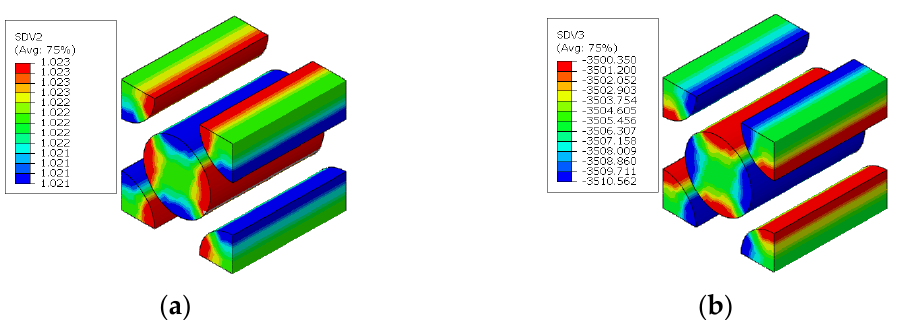
Figure 25. Failure indices and stress states in the fiber for fiber diamond distribution model. ( a )